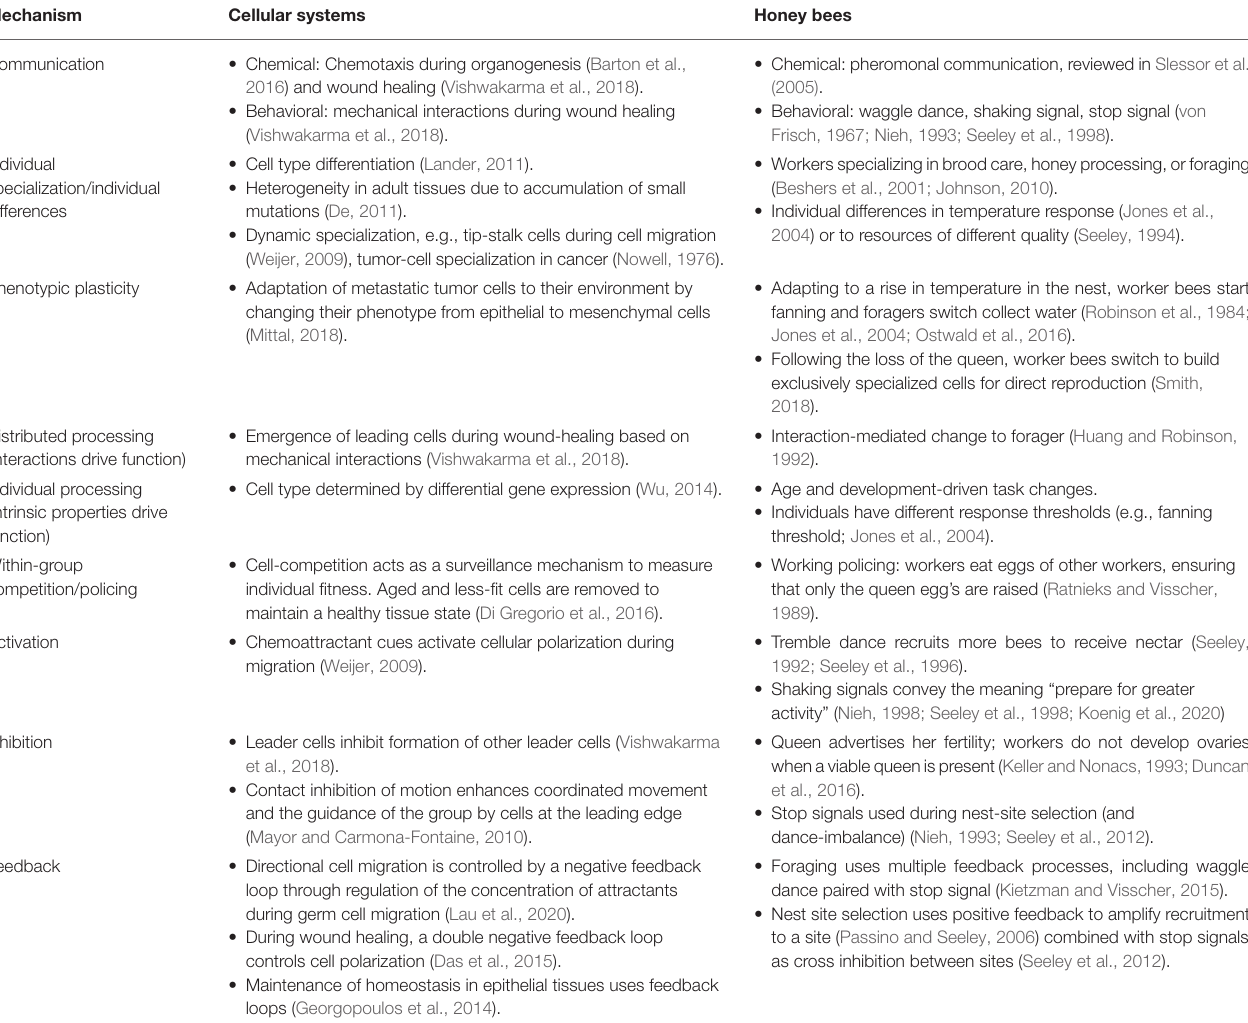
TABLE 1 | Examples of collective mechanisms for cellular systems and honey